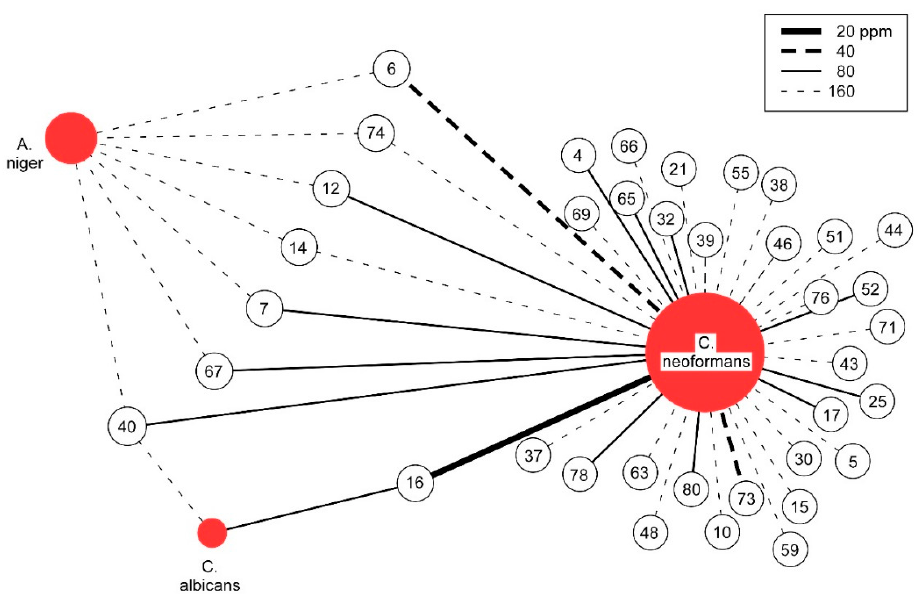
Figure 1. Graphical Analysis of Antifungal Activity. The antifungal activity of essential oils with MIC values at or below 160 ppm are depicted. Unshaded circles represent essential oils, numbered as noted in Appendix A. The strength of MIC is indicated by the line (see legend). Table 1. Fungal Susceptibility to Essential Oils. The number of essential oils having the indicated MIC value are shown for each fungal pathogen. Those meeting the MIC < 100 ppm significance criteria are shaded.